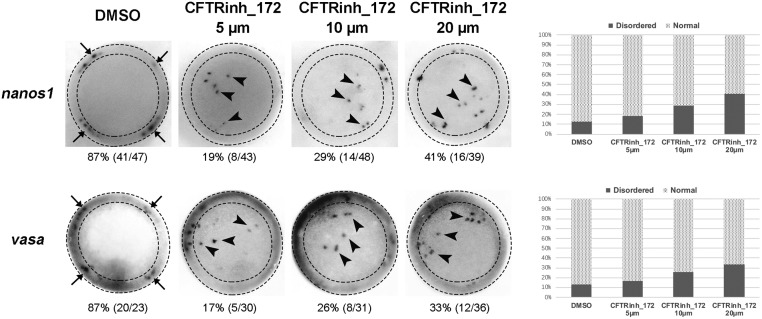
CFTR inhibitor CFTR_inh172 leads to PGCs disorder in early zebrafish embryo. Analysis of localization of nanos1/vasa positive cells in embryos by WISH at 50% Epiboly stage with top view.